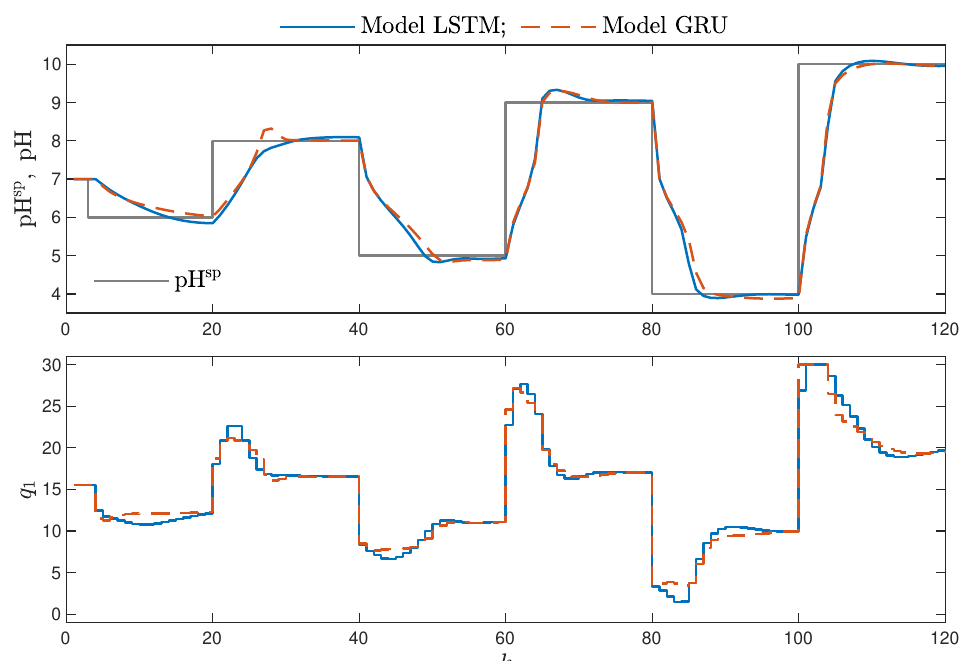
Figure 15. The neutralisation reactor: MPC results with the LSTM and GRU models for n N = 8, n A = 0, n B = 3.